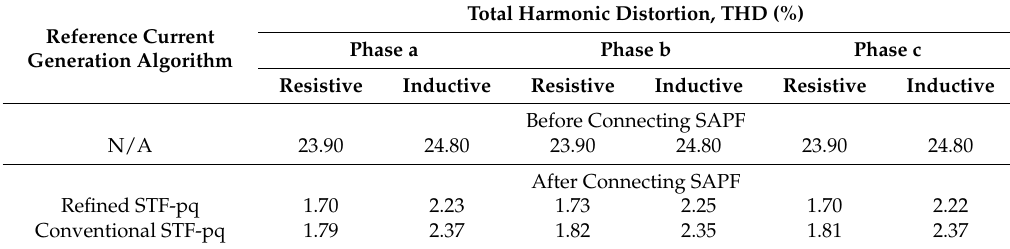
Table 2. THD values of source current i S under case 1 non-sinusoidal source voltage condition (Simulation Result). N/A: not applicable; STF-pq: self-tuning filter-based instantaneous power; SAPF: shunt active power filter.